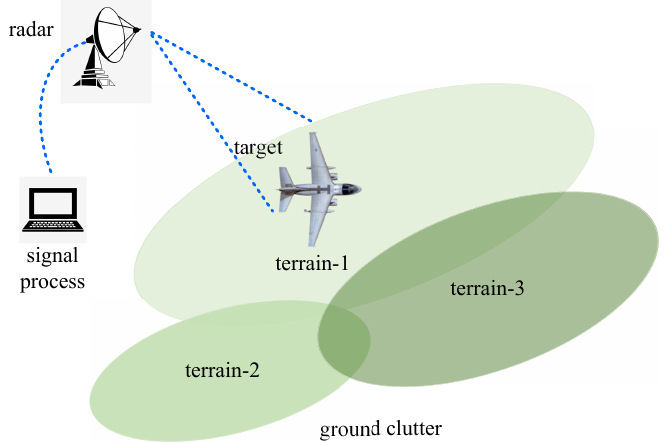
Figure 1. Schematic diagram of typical ground scenes. It depicts the terrain scene over which an aircraft target flies. This scene is a typical example of a complex ground scene, which is the original intention of this